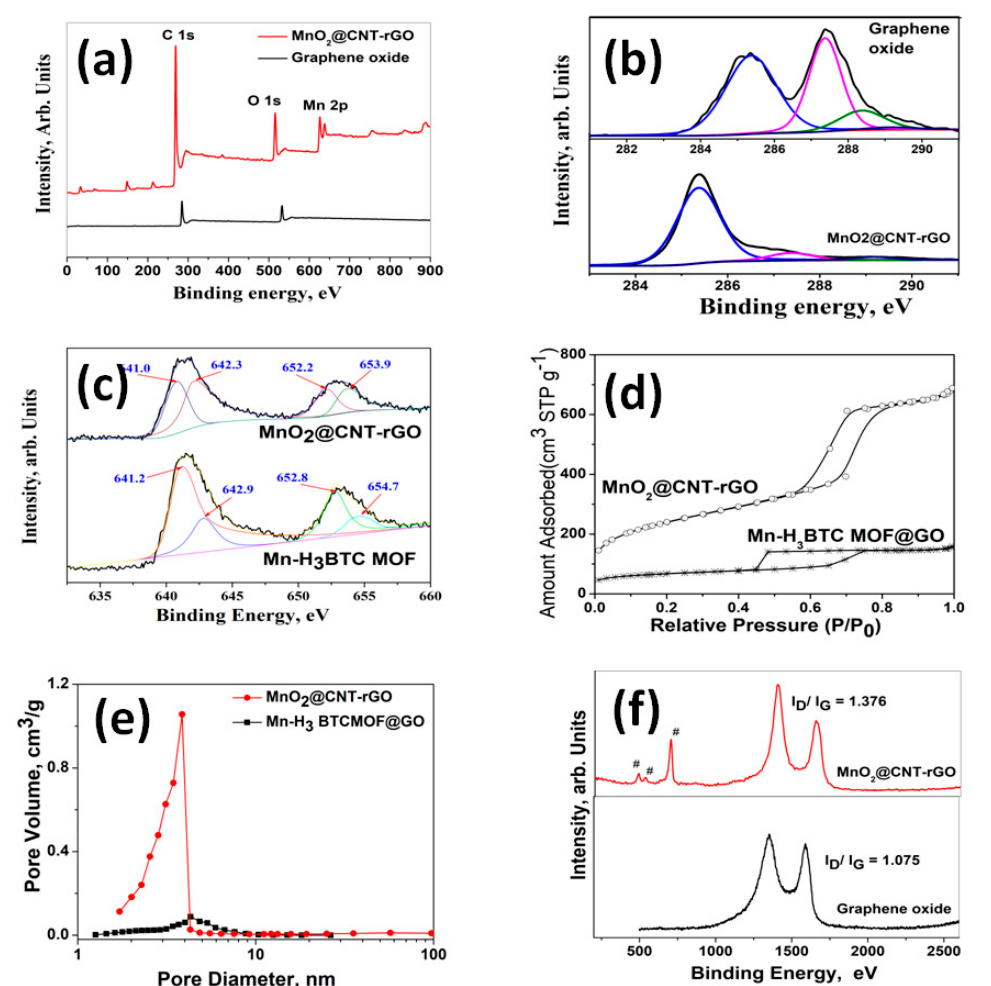
Figure 2. XPS survey spectra of MnO 2 @CNT-rGO and graphene oxide ( a ); deconvoluted C1 s spectra of MnO 2 @CNT-rGO and graphene oxide ( b ); deconvoluted Mn 2s spectra of MnO 2 @CNT-rGO and Mn-H 3 BTC MOF ( c ); nitrogen adsorption isotherms ( d ) and pore size distribution ( e ) of MnO 2 @CNT-rGO and Mn-H 3 BTC MOF; and Raman spectra of MnO 2 @CNT-rGO and GO ( f ).